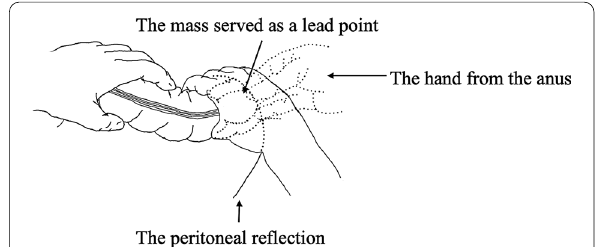
Fig. 3 Combined transabdominal and trans-anal procedure. We pushed the mass, which is located distal of the peritoneal reflection, through the anus to the oral side. Subsequently, we used the Hutchinson maneuver